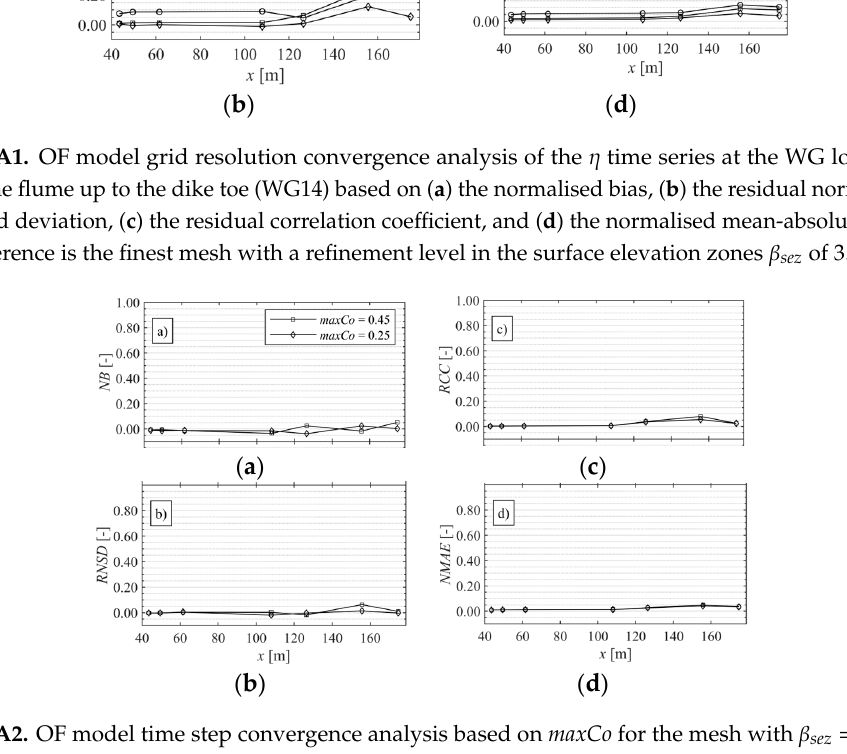
for a dike-promenade